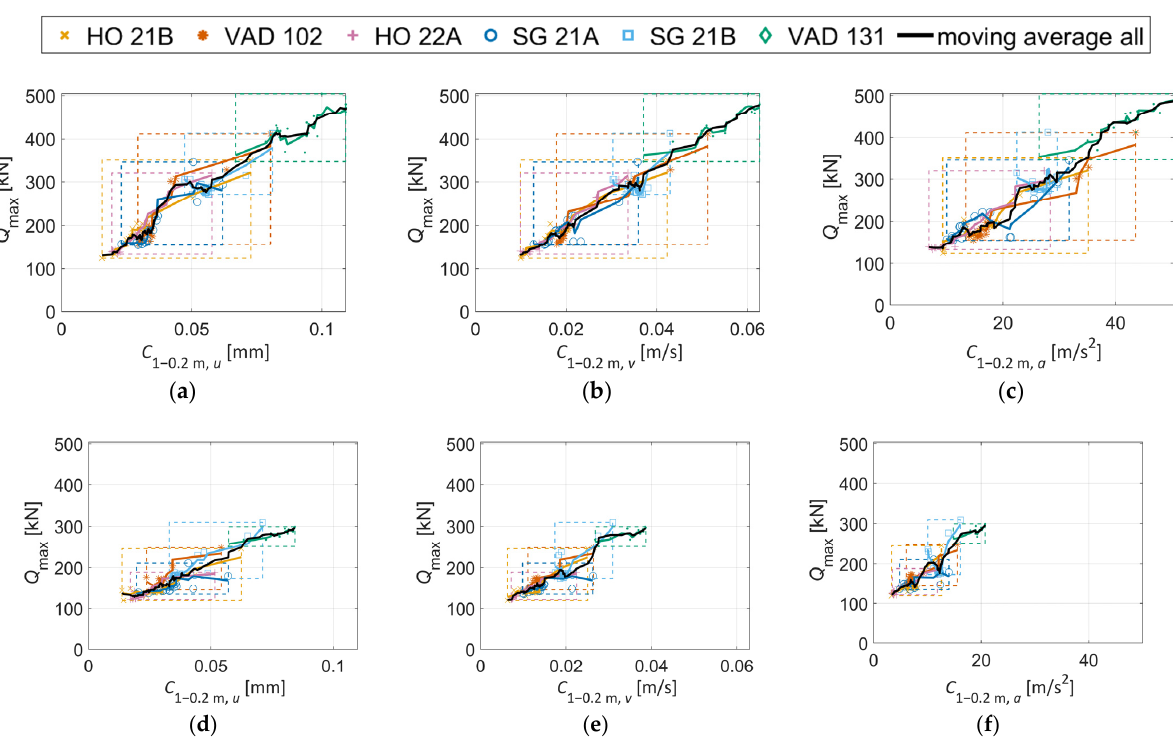
Figure 16. Relation between simulated Q max and 𝐶 (cid:2869)(cid:2879)(cid:2868).(cid:2870) (cid:2923),(cid:3082) for six different crossing panels (nominal parameters, stiff ( a – c ) and soft ( d – f ) rail to sleeper connection). The black, continuous line presents a 7-points moving average filter through the cloud of all scatter points. Dashed boxes (with the corresponding color) cover the min-max domain of results for each crossing